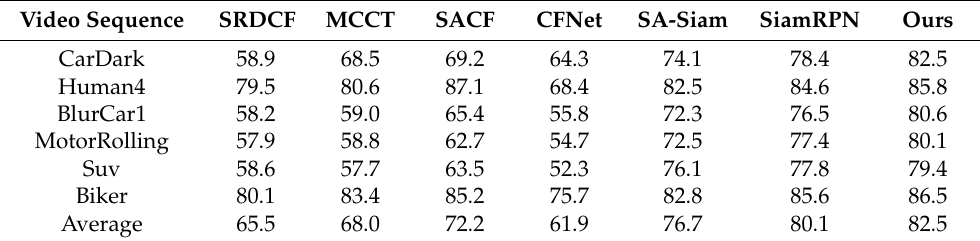
Table 3. The average OR (%) of the various object tracking algorithms in the testing sequences. Video Sequence